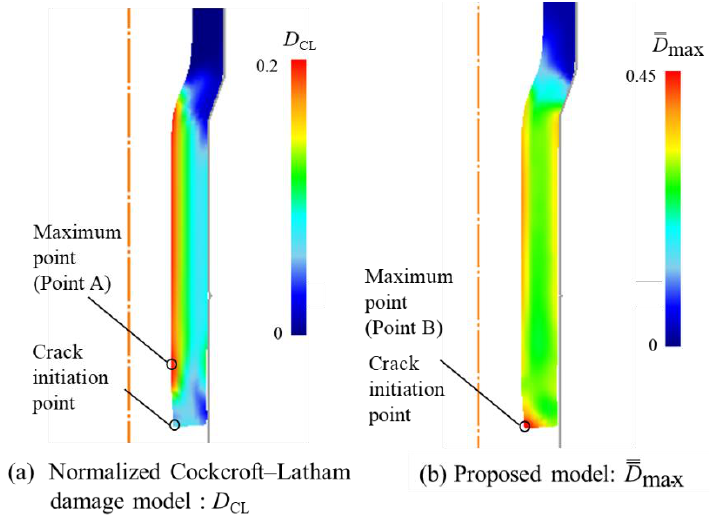
Figure 22. Distribution of ductile damage in first forward extrusion.